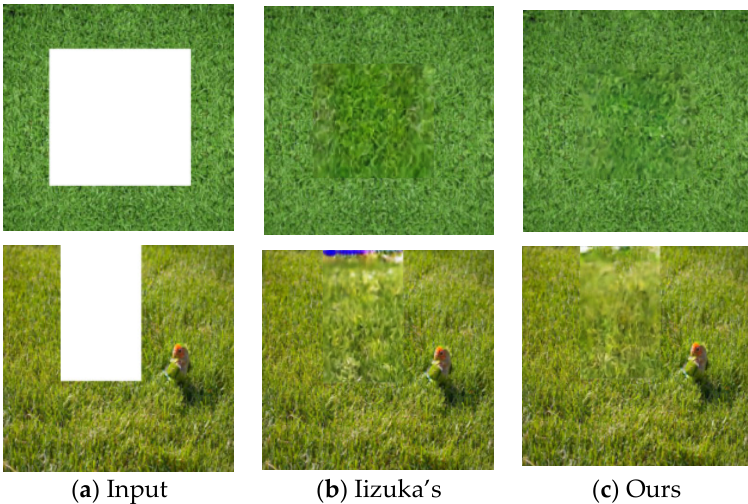
Figure 1. ( a ) A corrupted image to be completed; ( b ) The result of Iizuka’s method; ( c ) The result of our method.